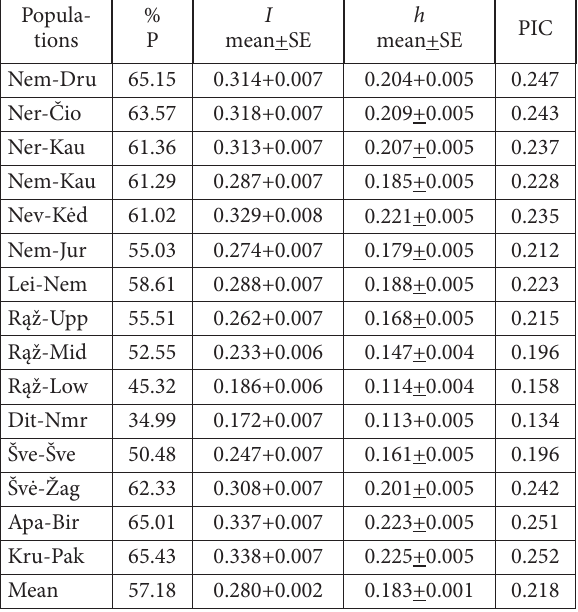
Table 2. AFLP loci based genetic diversity parameters of 15 Lithuanian populations of Lythrum salicaria